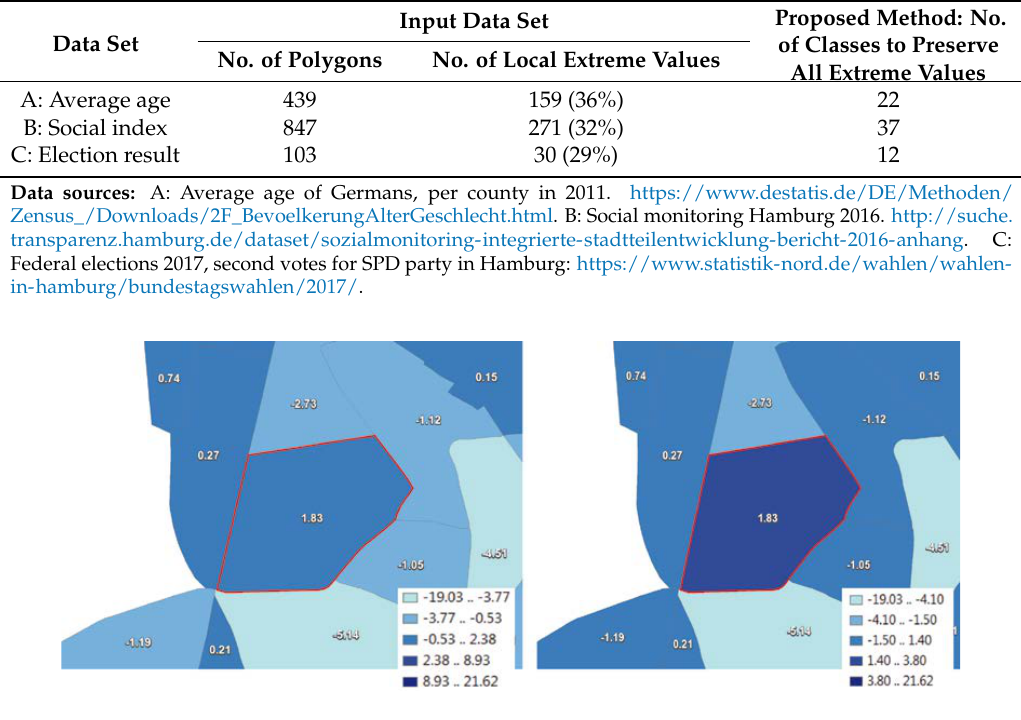
Figure 5. Better preservation of polygons with local extreme values using the proposed approach (red line) compared to conventional methods—the right axis shows number of classes, the upper axis shows preservation rate (data sources: see Table 4).